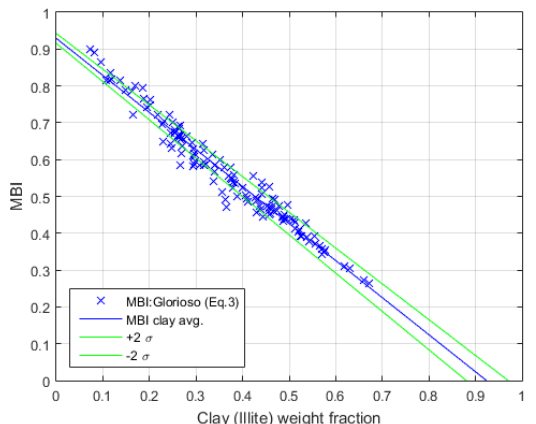
Figure 4. Correlation between the clay (illite) content and the MBI based on the correlation from Glorioso and Rattia [16] applied on the Marcellus Formation. The data are derived from the Marcellus Formation in West Virginia.